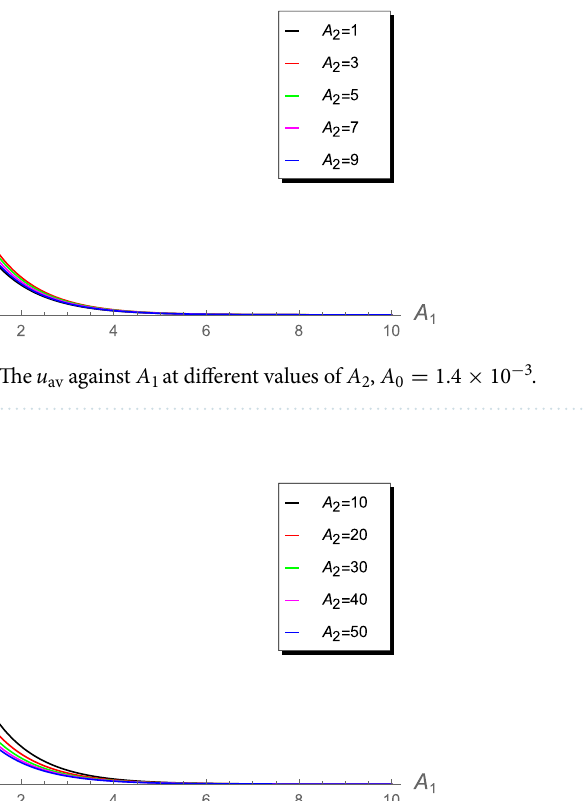
Figure 8. The u av against A 1 at different values of A 2 , A 0